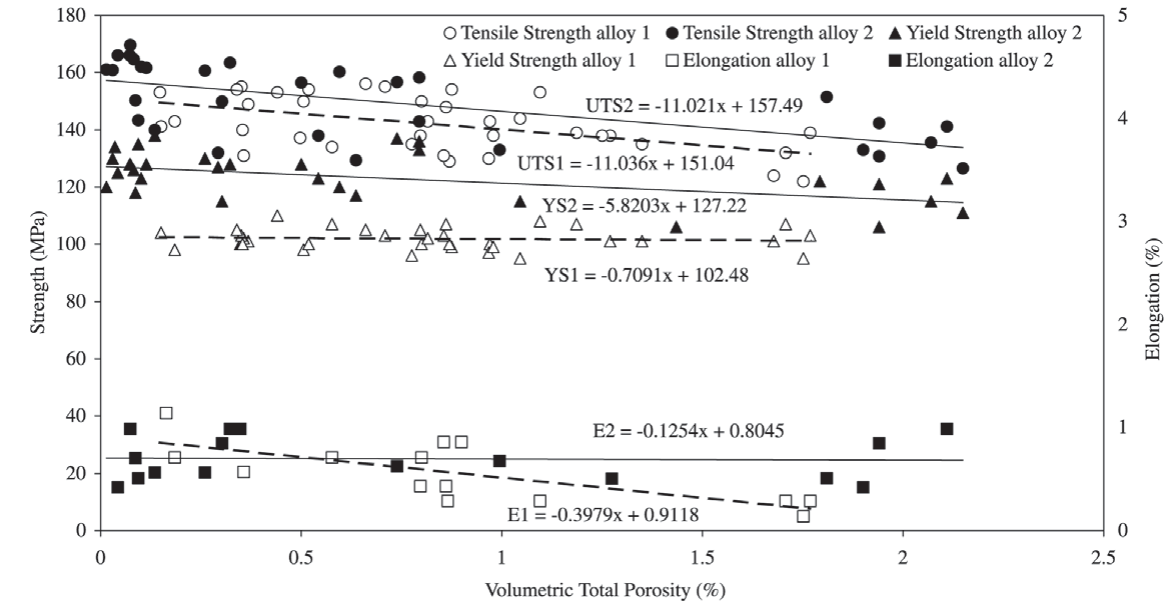
Figure 5. Tensile strength, yield strength and elongation rate as a function of volumetric porosity for the two alloys.